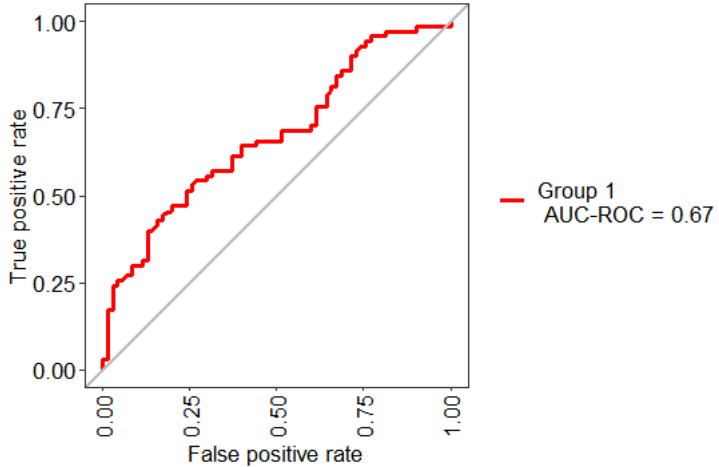
Figure 5. ROC curve obtained for the model based on the selected three features.